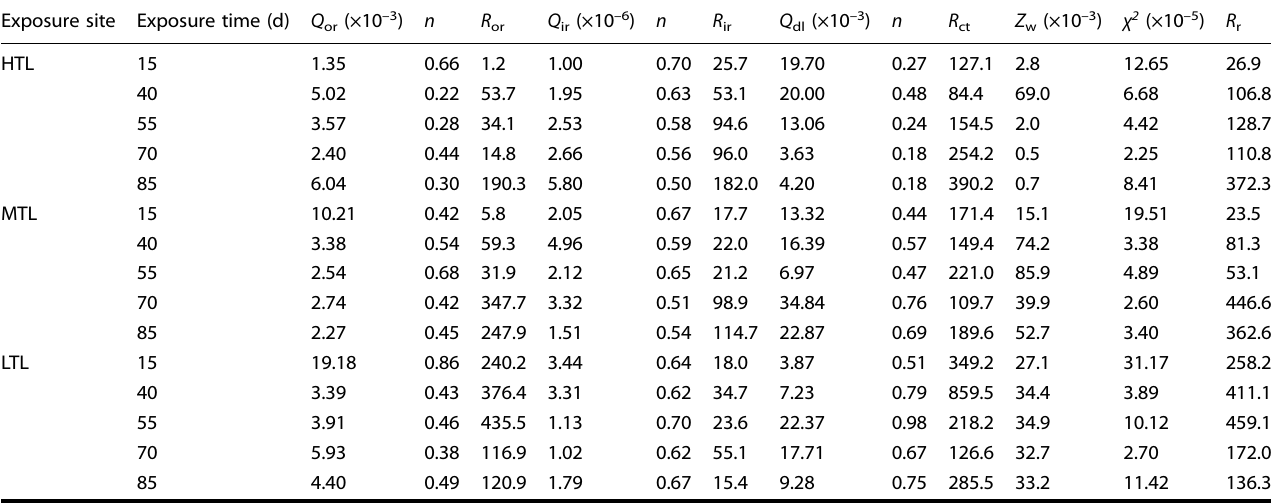
Table 1. Fitted EIS results of the AISI 4135 steel samples after exposure for different periods at different locations in the tidal zone. Exposure site Exposure time (d) Q or (×10 – 3 ) n